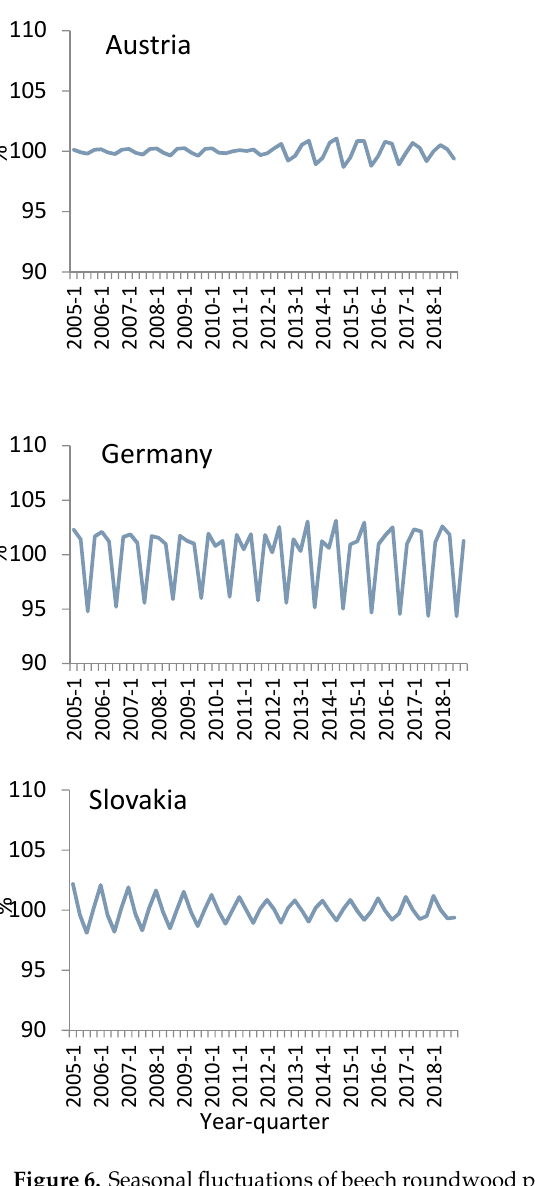
Figure 5. Long-term trend and cyclical fluctuations of beech roundwood prices in selected European countries in 2005–2018. Cyclical fluctuations (left axis) are expressed in € m − 3 as positive and negative deviations from the long-term trend at a given time point.